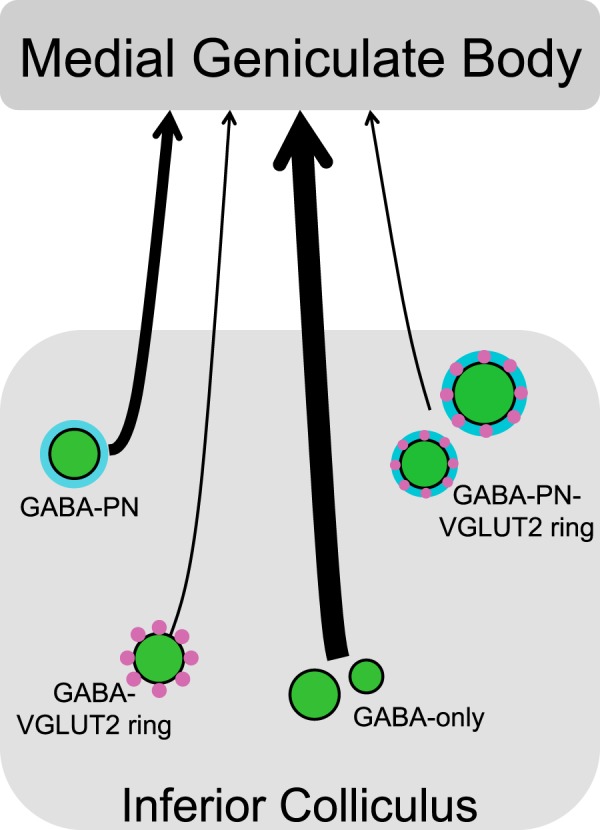
A range of soma sizes and subtypes of cells makes up the GABAergic portion of the IC–MG projection. Black arrows indicate the GABAergic IC–MG projection, with the weight of each arrow reflecting the proportion of the pathway that is made up of each GABAergic subtype. Green circles represent small, medium, and large GABAergic IC cells; subtypes are distinguished by the presence of perineuronal nets (cyan) and/or perisomatic rings of VGLUT2 immunopositive boutons (magenta).